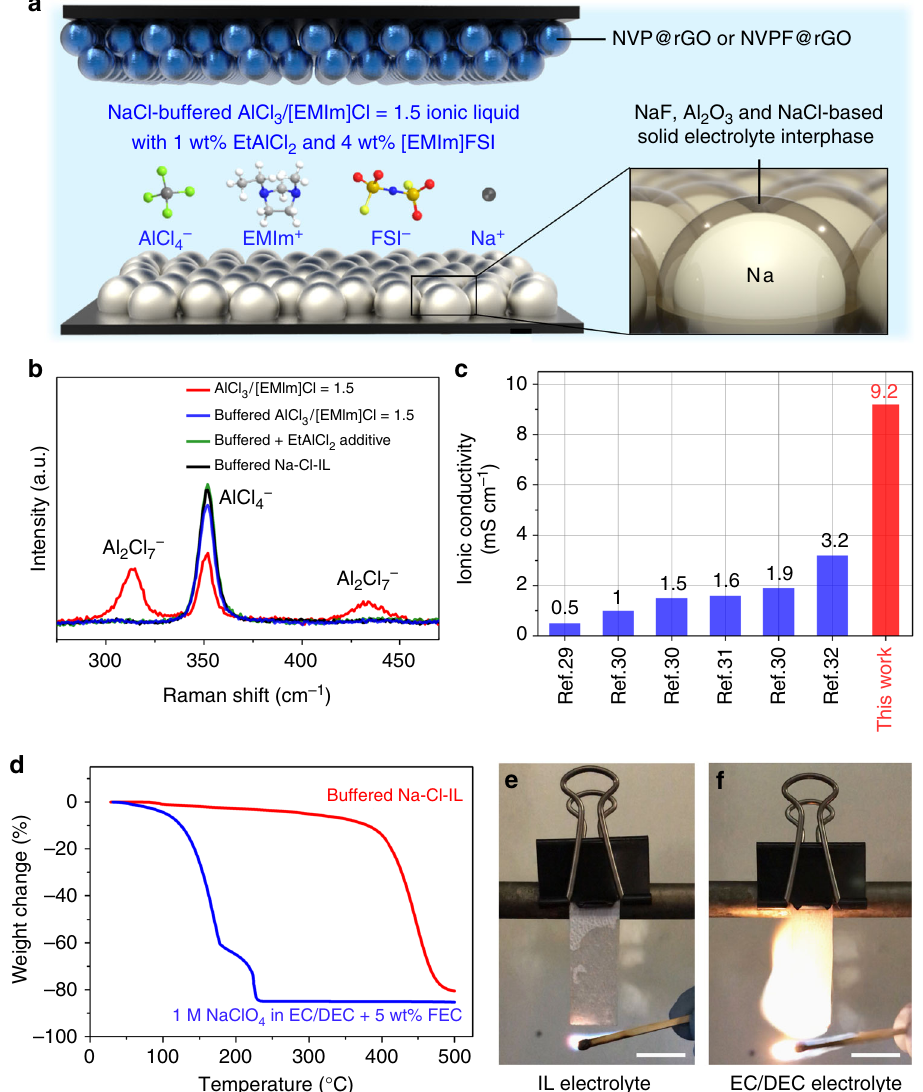
Fig. 1 Properties of the buffered Na – Cl – IL electrolyte. a Schematic illustration of the battery con fi guration and electrolyte composition of the IL electrolyte. b Raman spectra of ILs based on AlCl 3 /[EMIm]Cl = 1.5 with different additives. c Ionic conductivities of buffered Na – Cl – IL and other IL-based electrolytes for Na batteries at 25 °C 29 – 32 . d – f Thermal stability ( d ) and fl ammability tests using buffered Na – Cl – IL ( e ) and conventional 1.0 M NaClO 4 in EC:DEC (1:1 by vol) with 5 wt% FEC electrolytes ( f ). Scale bars in ( e , f ), 1